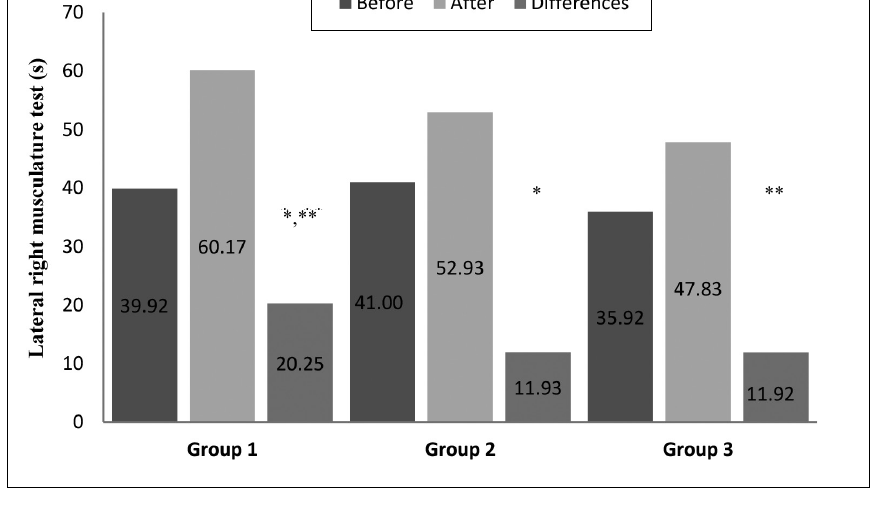
Figure 5. McGill trunk